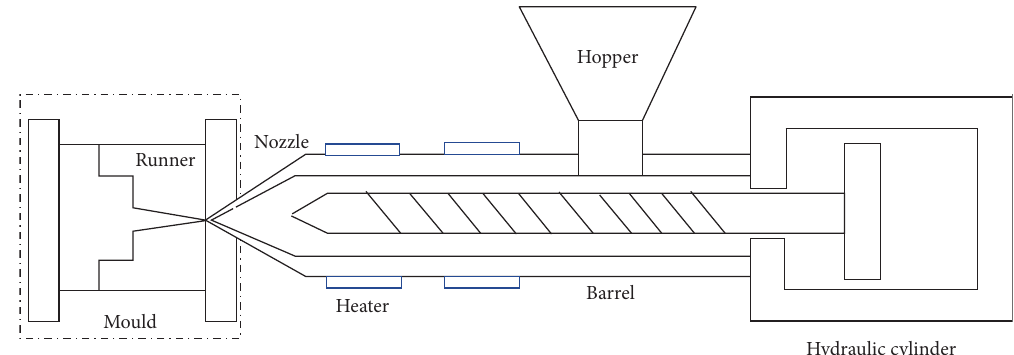
Figure 1: Schematic diagram of injection molding